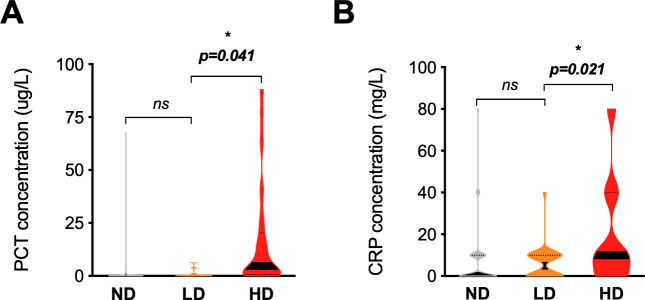
Distribution of inflammatory markers between patients with LD, HD, or ND parasitemia.Violin plots showing the distribution in the concentrations of (A) PCT and (B) CRP found among ND, LD, and HD groups. Thick black bands: median. Dotted lines: quartiles. CRP was measured using a categorical quantitation test. Four categories exist: <10 mg/L, 10–40 mg/L, 40–80 mg/L, and >80 mg/L. The lower limit of this range is represented in the plot. *p < 0.05. CRP, C-reactive protein; HD, high-density Pf infection; LD, low-density Pf infection; ND, undetectable Pf parasitemia; ns, nonsignificant; PCT, procalcitonin; Sd-mRDT, standard malaria rapid diagnostic test; us-qPCR, ultrasensitive quantitative PCR.